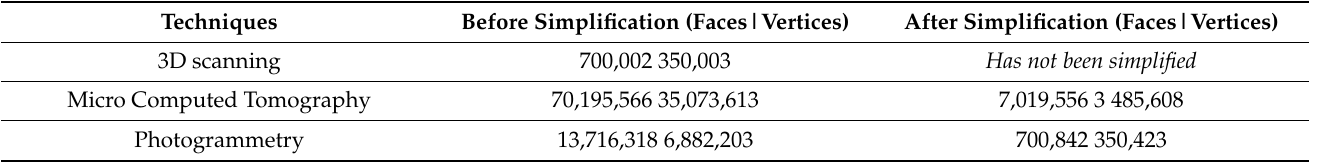
Table 4. The size of an obtained texture map of 3D models.